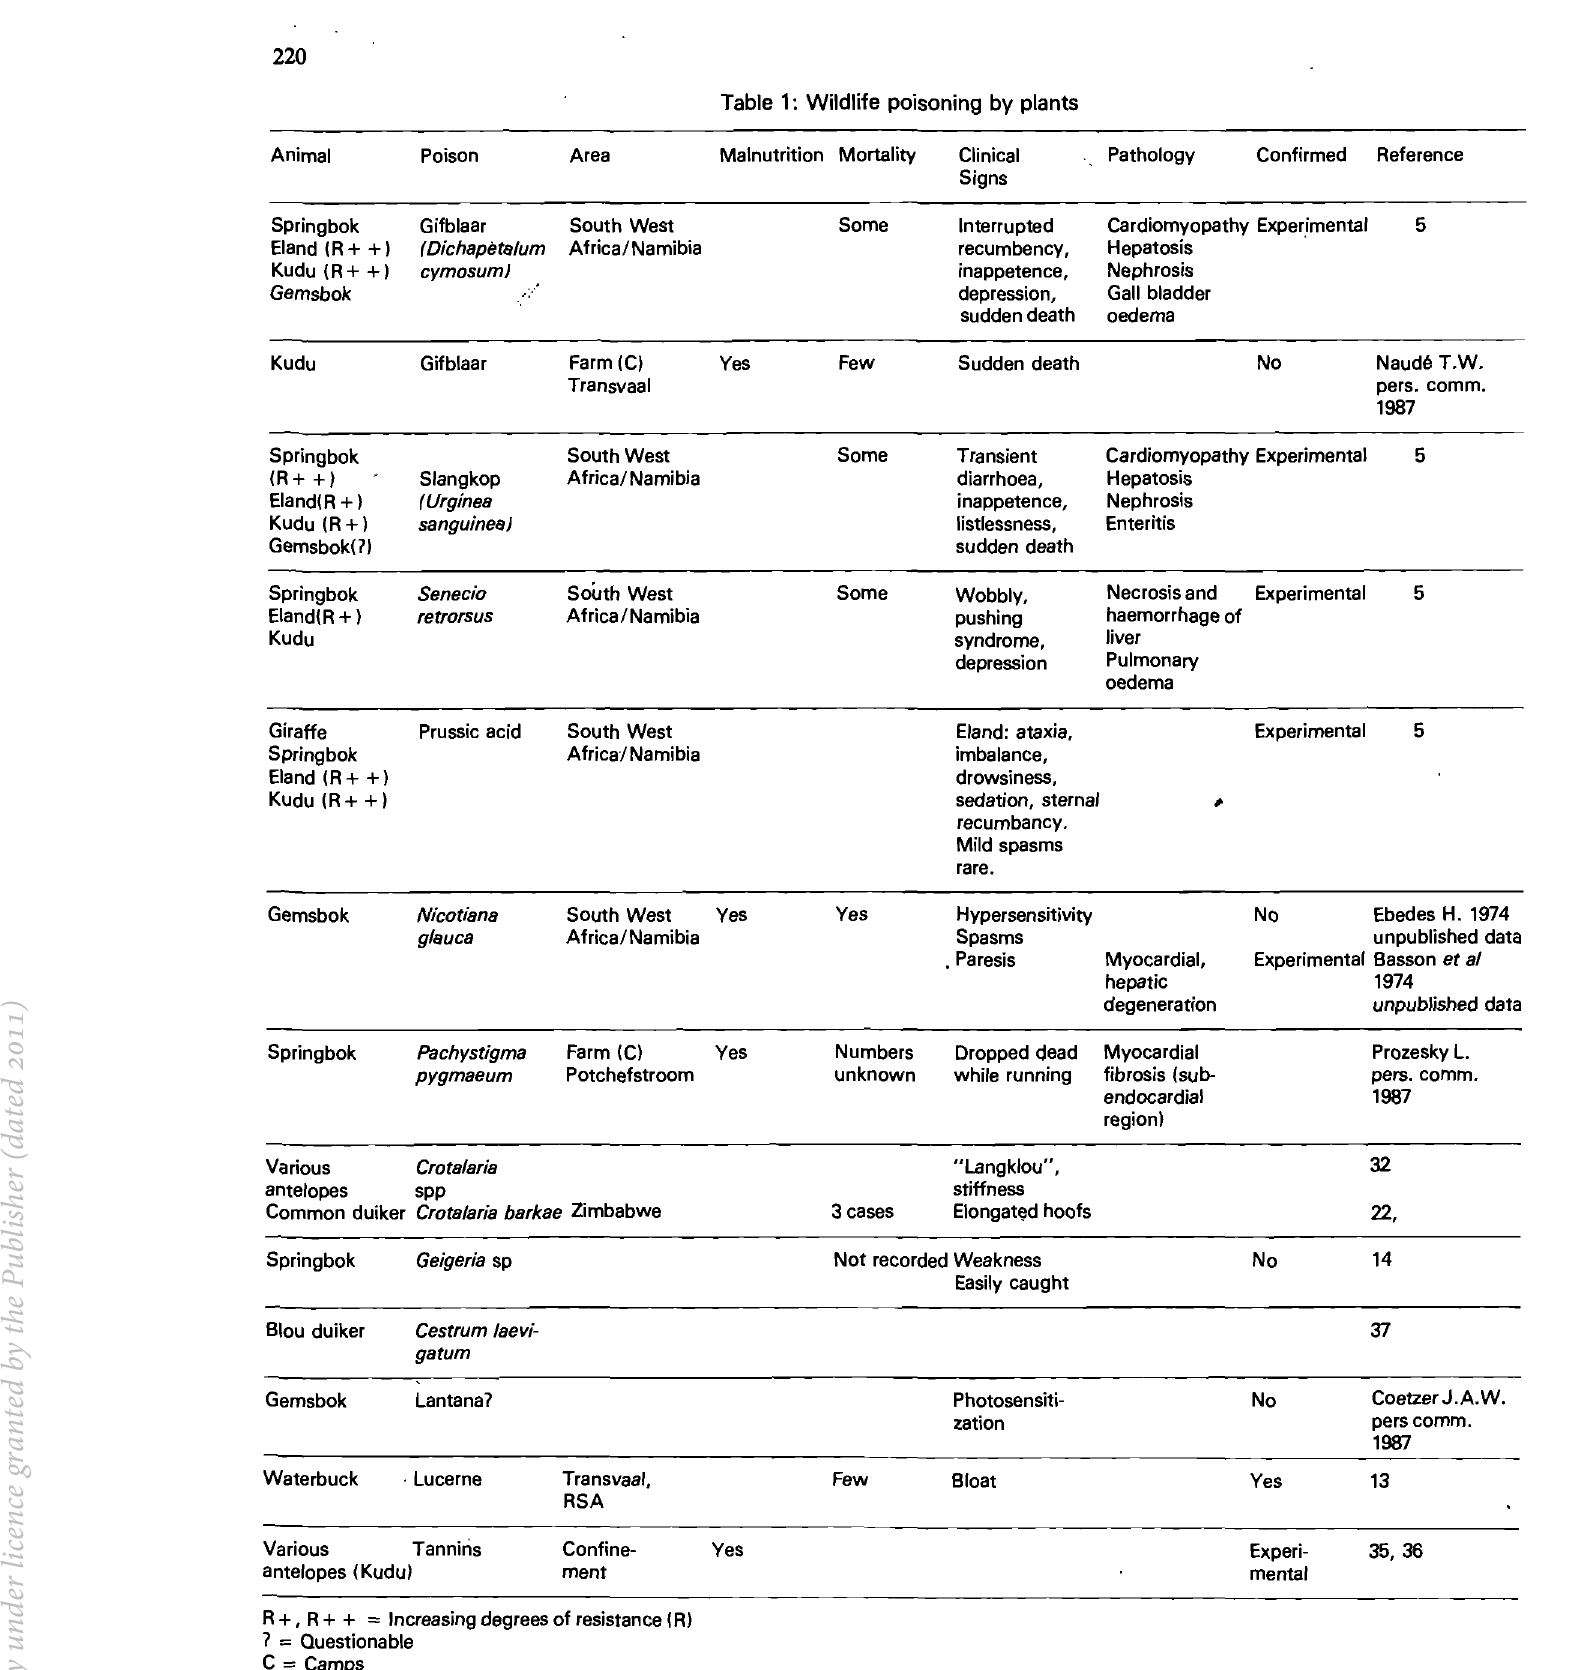
Table 1: Wildlife poisoning by